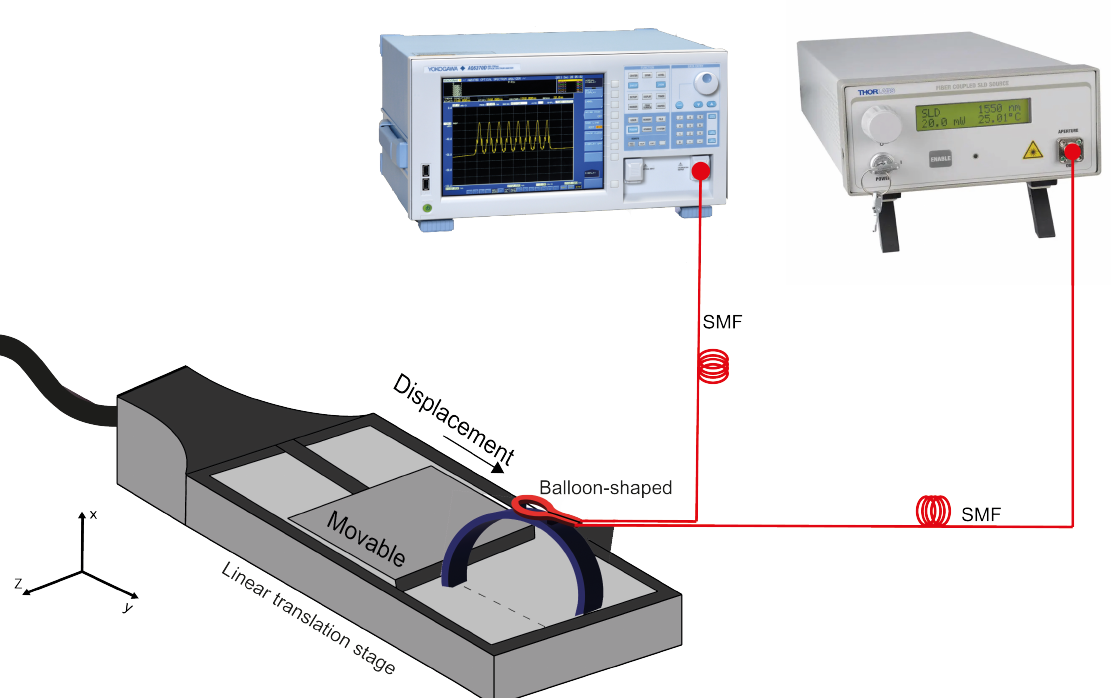
Figure 5. Schematic of the proposed experimental